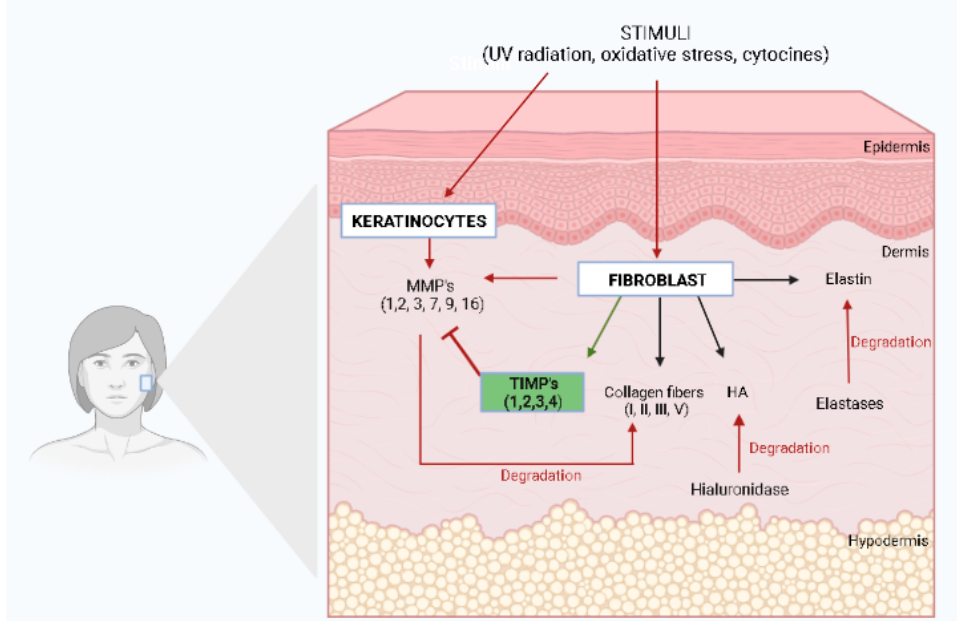
Figure 1. Extracellular matrix components (ECM) and skin elasticity. HA, Hyaluronic Acid; MMPs, Metalloproteinases; TIMPs, Tissue Inhibitor of Metalloproteinases. The illustration was drawn using BioRender software.